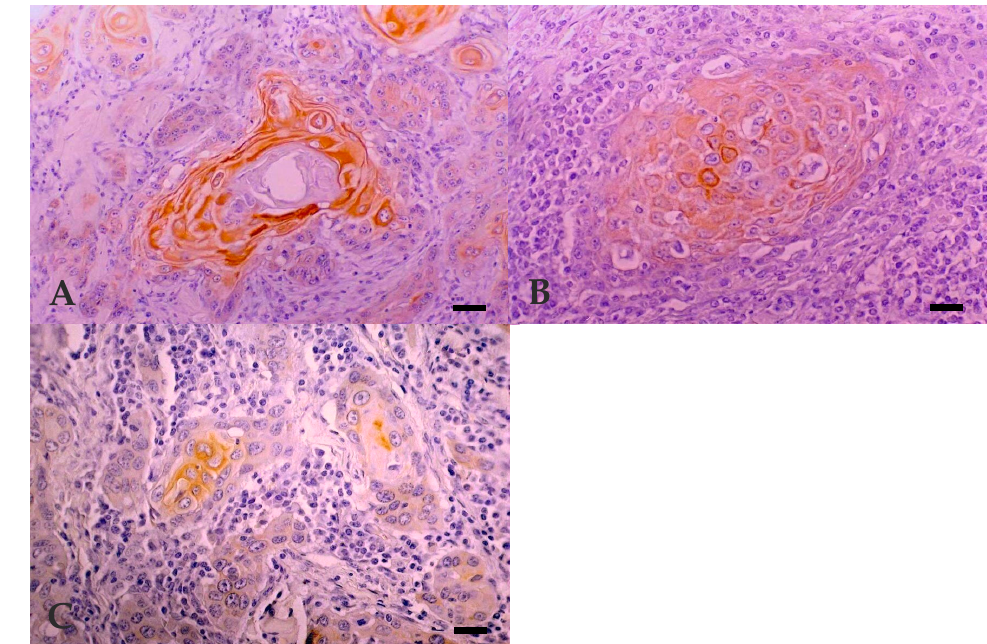
Figure 3. Expression of cytokeratin marker LP34 in BOSCC. ( A ) WD: cytoplasmic di ff use and intense immunoreactivity, seen mostly in well-di ff erentiated tumour cells but also in dysqueratotic and acantolytic cells. Bar, 50 µ m. ( B ) MD: cytoplasmic di ff use and reaction in fewer well-di ff erentiated keratinocytes. Bar, 25 µ m. ( C ) PD: cytoplasmic di ff use and intense reaction, only in a limited number of well-di ff erentiated tumour cells in the centre of islands. Bar, 25 µ m. Immunohistochemistry using avidin-biotin complex method, Mayer’s Hematoxylin